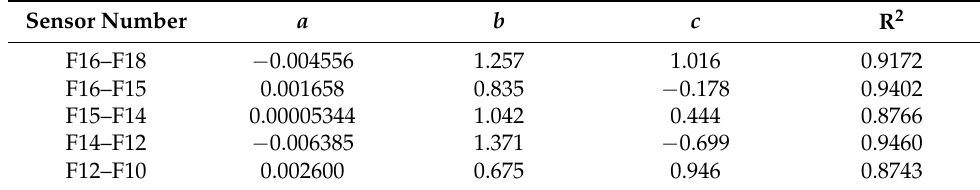
Table 2. Parameters of sensor calibration regression